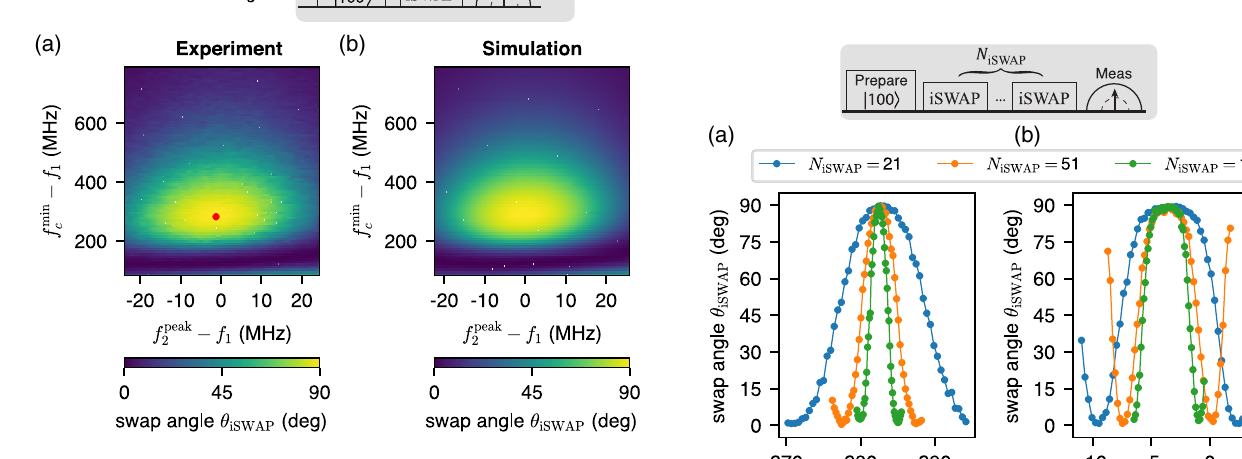
FIG. 31. Tune-up measurement for the iSWAP gate. (a) Exper- imental data of tune-up measurements for a 30-ns-long iSWAP gate. We measure the iSWAP angle θ as functions of iSWAP FIG. 32. Experimental data of fine-tuning measurements for the QB 2 Z -pulse amplitude ( x axis) and CPLR Z -pulse amplitude iSWAP gate. (a) Measurements of the swap angle θ ( y axis). The control sequence to measure the iSWAP angle is multiple iSWAP pulses to finely adjust the CPLR Z amplitude illustrated at the top. A red circle denotes an optimal parameter set ( f min ). (b) Measurements of the swap angle θ that maximizes θ . (b) Numeric simulation reproducing the c iSWAP experimental data of tune-up iSWAP pulses to finely adjust the QB2 Z amplitude ( f peak 2 ).